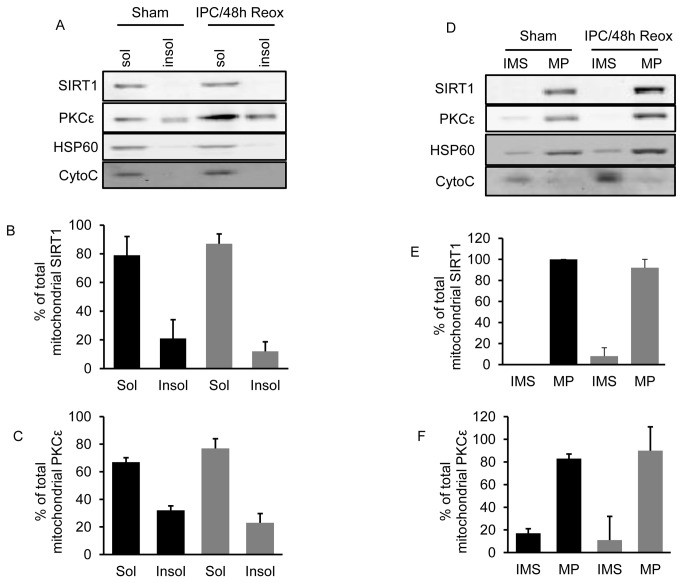
SIRT1 localizes to the mitoplast fraction.Mitochondria from sham or IPC-treated neuronal cultures were exposed to alkaline extraction and the localization of SIRT1, PKCε, cytochrome c (an intermembrane space marker), and HSP60 (a matrix marker) was determined by Western blot analysis (A). Western blot quantitation of SIRT1 and PKCε levels in the soluble (sol) and insoluble (Insol) fractions are shown in (B and C) (n = 3). In (D), SIRT1 and PKCε localizations were determined in mitoplasts (MP) and intermembrane space (IMS) fractions generated by hypoosmotic lysis of the outer mitochondrial membrane. Western blot quantitation of SIRT1 and PKCε levels in MP and IMS fractions are shown in (E and F) (n = 3). No significant difference (p > 0.05) was observed in the localization of SIRT1 or PKCε following IPC exposure when compared to sham controls. Data are means ± SEM.